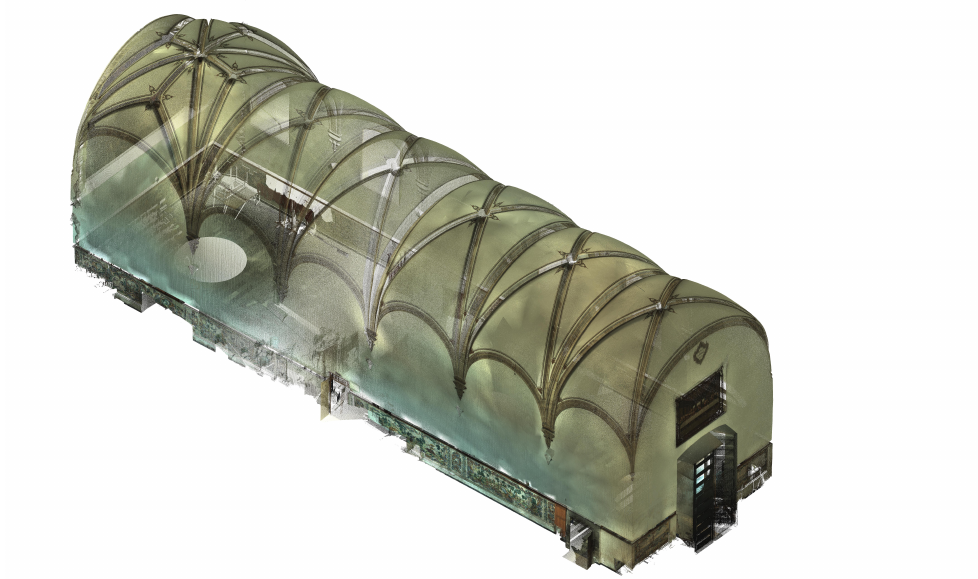
Figure 5. Top axonometric view of the geometrical vaults arrangement. Data collection with the Laica Scan Station C10 Laser Scanner was carried out at different times, before the start of the works (2015) and after completion of the works (2019), choosing a position centred in the Refectory on a tripod, so that the scanning distances were, at most, of the order of 15 m. The intermediate state of the works was recorded with six locations on different dates (2018 and 2019) given that the demolition and reconstruction process took place in different phases, each one corresponding to each span (five arches and six vaults). Similarly, and coinciding with the days on which it was scanned, the state of the work was also recorded with the Canon 600D SLR digital camera. Using the Cyclone Leica software for cloud recording and 3DReshaper for cloud analysis and deformation control, the point cloud obtained from the different scans was processed, and above all, the “Cloudcompare” software was used to analyse the data from the different states of the work, taking certain characteristic points as a reference, and carrying out verification tests so that the distances between them were constant in the stages